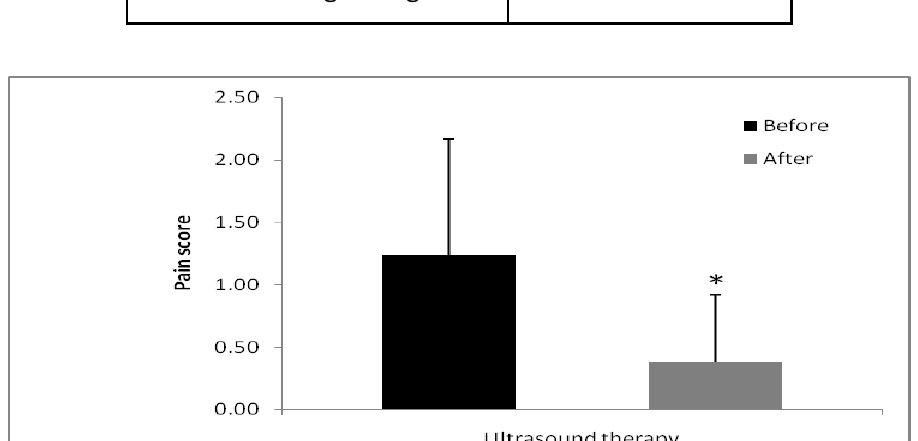
Fig. 1: Ultrasound treatment on the pain score resulted from stiffness of elbow joint.. * p <